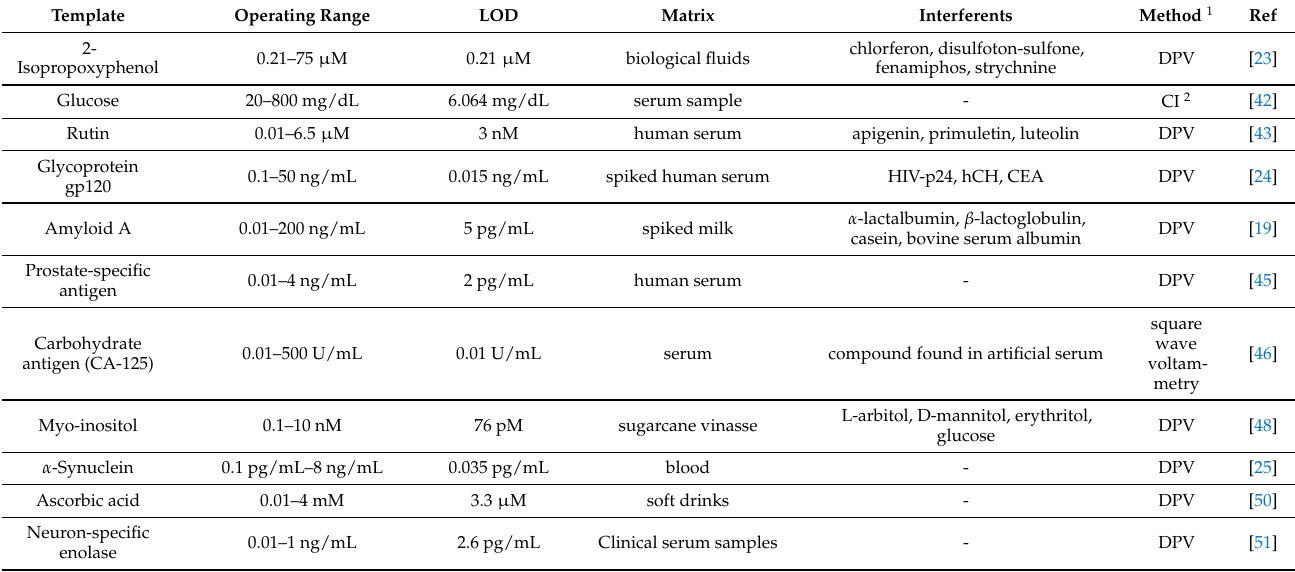
Table 3. Bio-active substance sensing performance of MIPPy-based